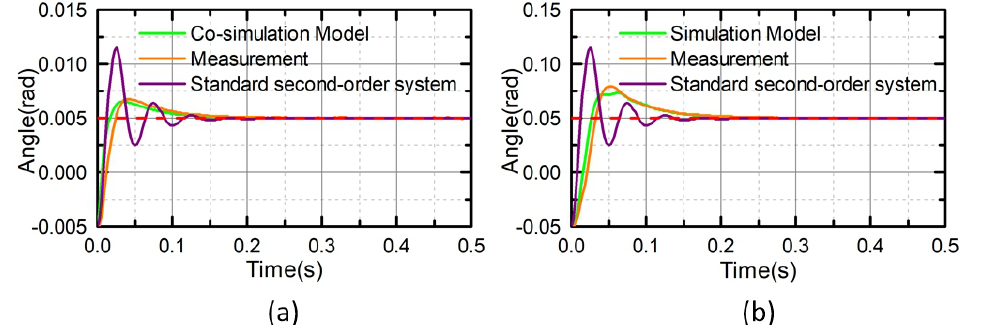
Figure 9. Measurement, traditional simulation model, and proposed simulation results. ( a ) γ = 5 mrad, ( b ) γ = 50